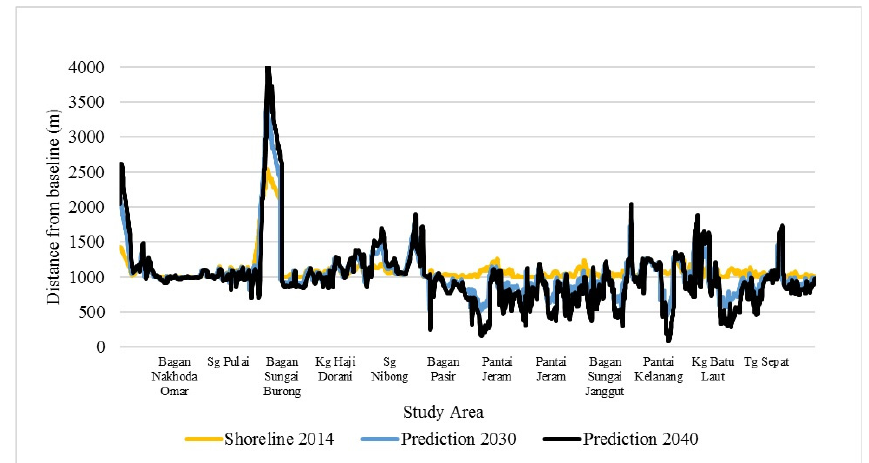
Figure 7. Prediction of shoreline changes for the years 2030 and 2040.